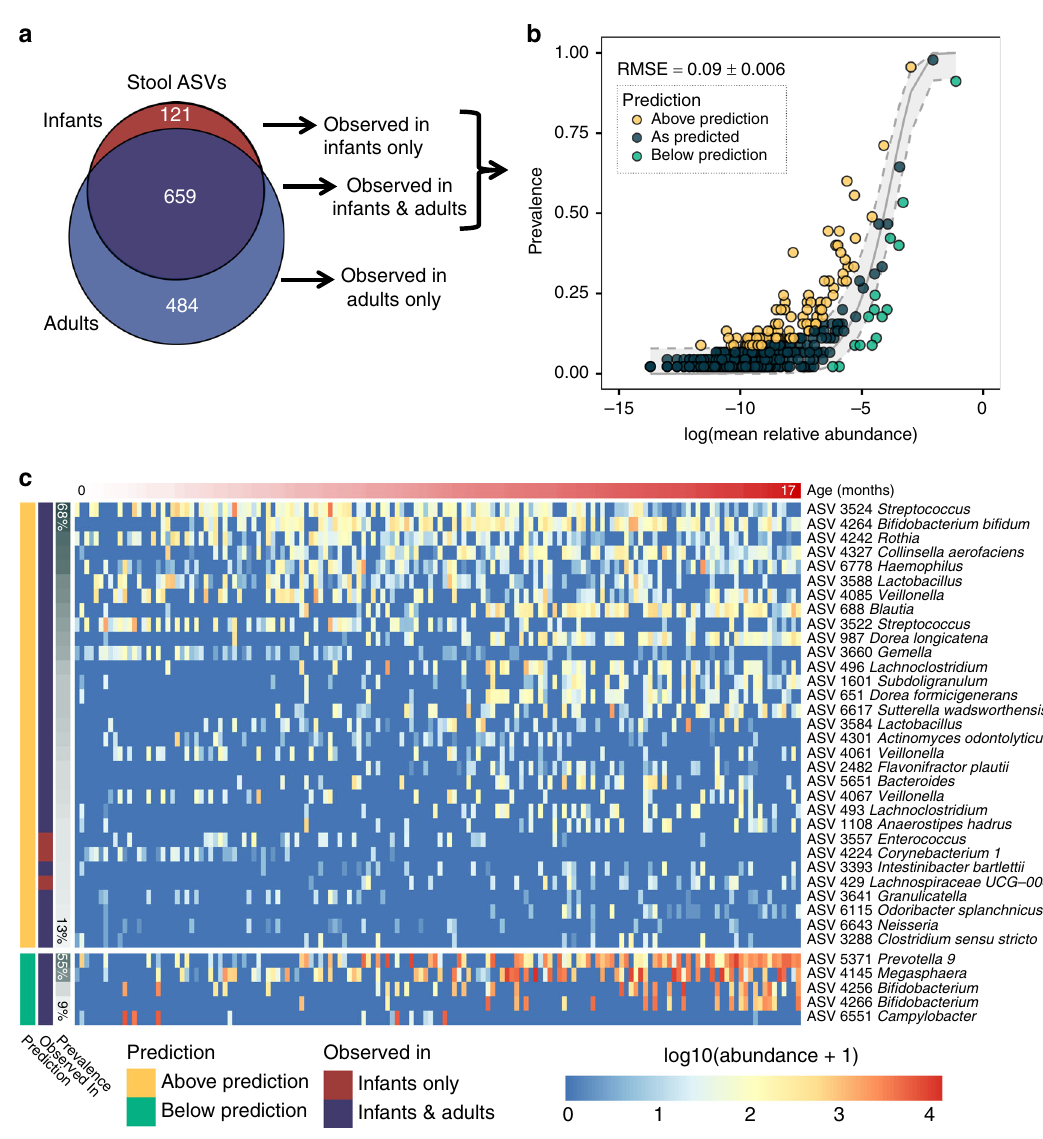
Fig. 3 Infant stool microbiotas assemble according to neutral rules. a Venn diagram showing the number of ASVs observed in infant and adult stool samples. Only taxa found in infant stool samples were included in panels ( b ) and ( c ). b Neutral community model (NCM) fi t to each ASV observed in the stool of Tsimane infants. Points are colored according to whether the taxon prevalence in infant samples was above (yellow), at (blue), or below (green) the predicted prevalence according to the NCM. Average RMSE (±standard deviation) was calculated from 1000 bootstrap resamplings. c Heatmap of the log 10 normalized abundances of the ASVs from infant stool samples that were observed either to be consistently above (yellow) or below (green) their predicted prevalence in part ( b ). Rows are sorted by taxa prevalence; columns are sorted by the subject ’ s age (months). Source data are provided in the Source Data fi